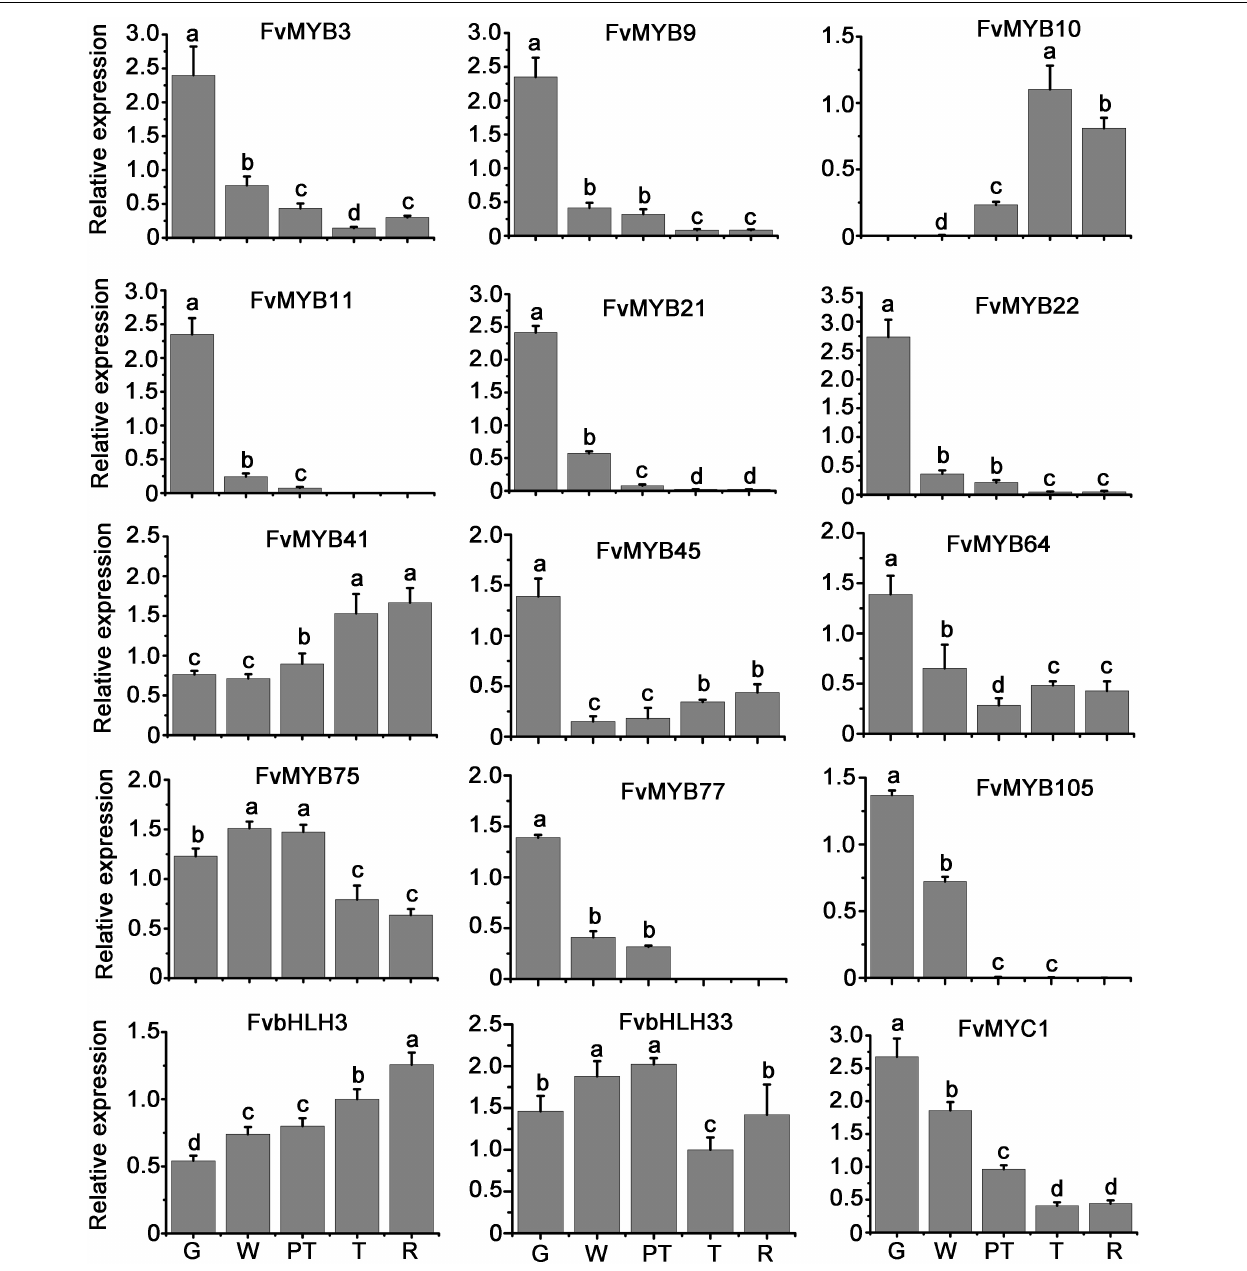
FIGURE 2 | Relative expression levels of MYB and bHLH genes in fruits of different development stages. Values were normalized to the expression level of an internal control, Fv26S . Data are presented as the mean of biological replicates ± SD ( n = 3). G, green stage; W, white stage; PT, pre-turning stage; T, turning stage; R, ripe stage. The letters a–d indicate statistically significant differences, as determined by Tukey’s LSD test ( P ≤